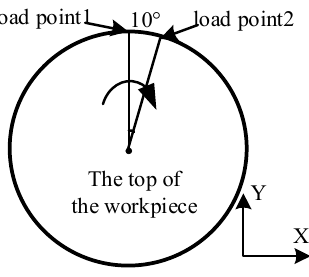
Figure 5. Diagram of cutting force load point position.